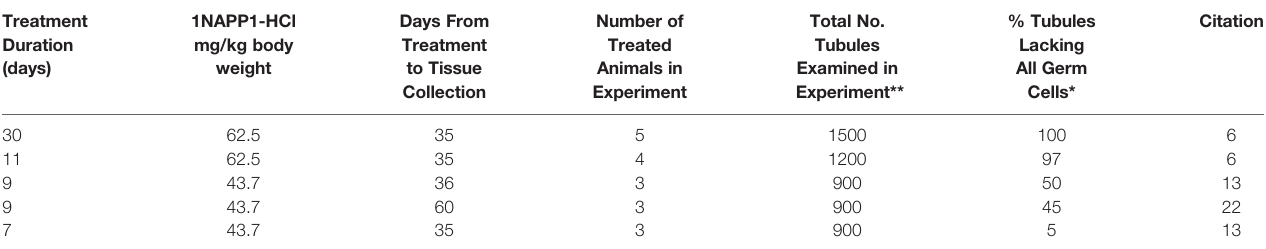
TABLE 1 | Effect of the duration of treatment of mice with 1NAPP1-HCl on the percent of Seminiferous Tubules that lack all Spermatogenic Cells 35 or 60 days after treatment. Treatment 1NAPP1-HCl Days From Number of Total No. % Tubules Citation Duration mg/kg body Treatment Treated Tubules Lacking (days) weight to Tissue Animals in Examined in All Germ Collection Experiment